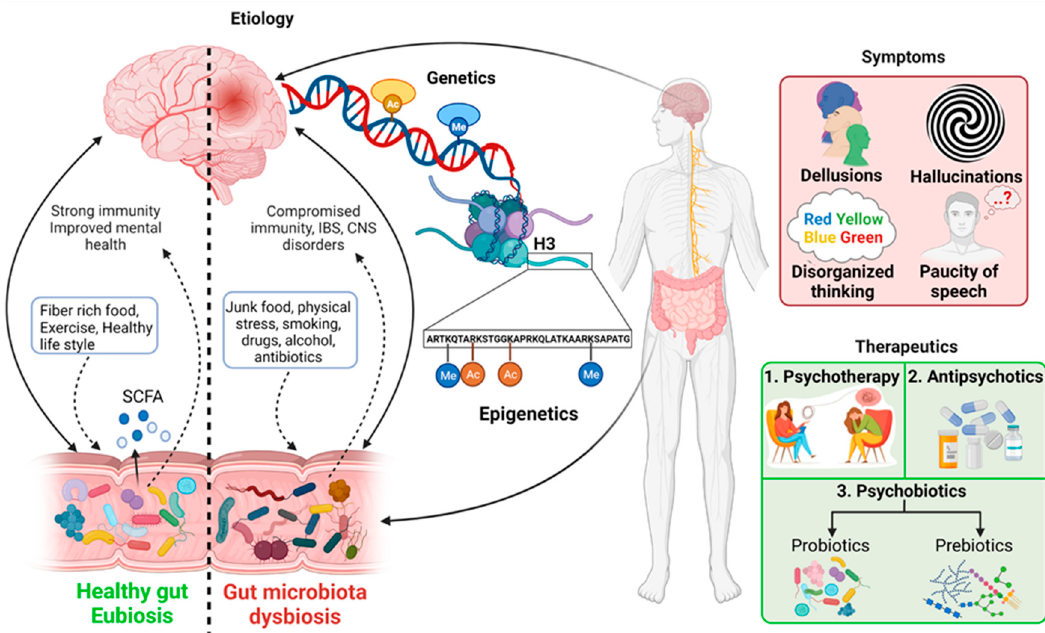
Figure 1. Symptoms, factors involved, and current therapeutics in schizophrenia . A combination of genetics, epigenetics, environmental factors, including gut microbiota, resulting in the prognosis of the illness. Schizophrenia involves variable symptoms having limited therapeutic options. On the left side of the figure, solid arrows indicate the potential etiology (genetics, epigenetics and gut microbiota dysbiosis) of schizophrenia and the dotted arrows are representing bi-directional relation of gut microbiota in health and disease.